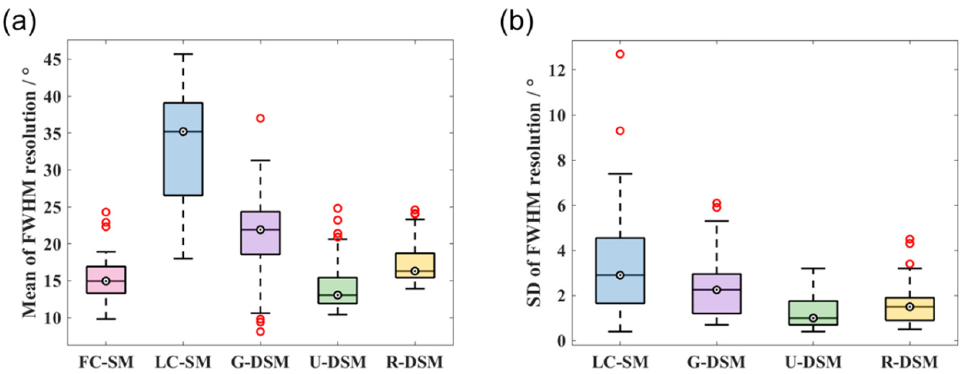
Figure 23. Box plots of ( a ) mean values and ( b ) SD values of FWHM resolution at 36 different source positions for 137 Cs source in inter-device evaluation.